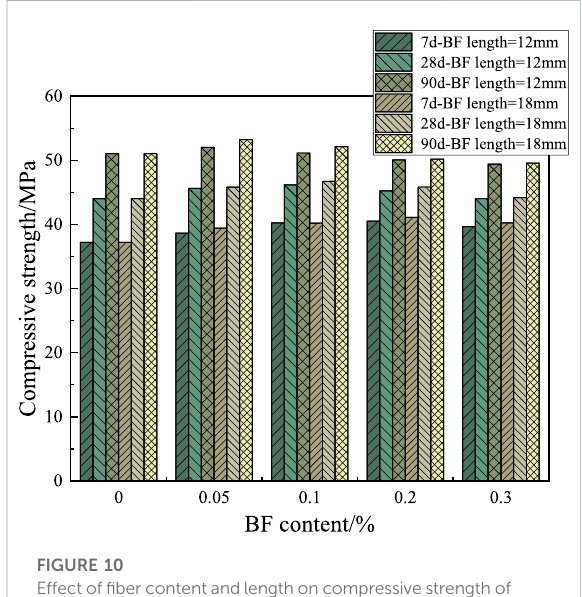
FIGURE 10 Effect of fi ber content and length on compressive strength of concrete at 7, 28, and 90 d (Li,